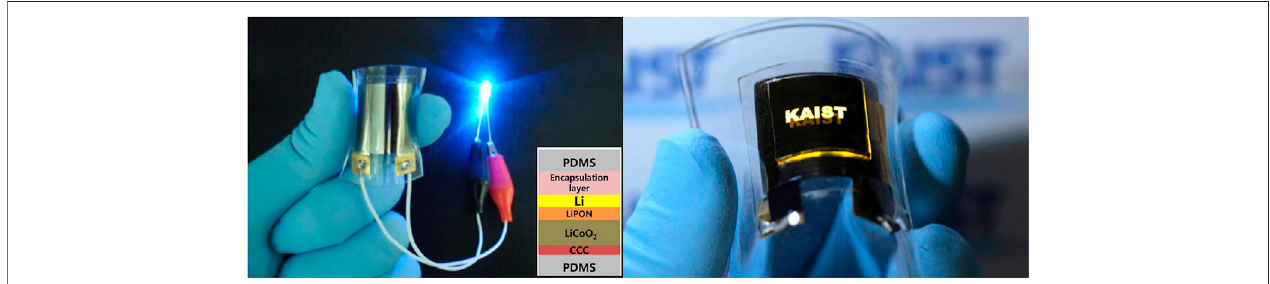
FIGURE4| Photographofabendable LIBturningonablue LEDinbentcondition.Theinsetshowsthestackedlayersinthe fl exibleLIBand thepictureofanall-in- one fl exible LED system integrated with a bendable LIB. Reprinted with permission from Koo et al. (2012). © 2012 ACS.